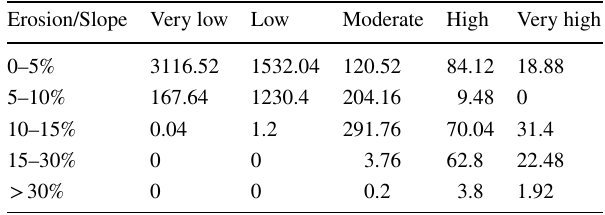
Table 8 Relationship between erosion sensitive area and slope Erosion/Slope Very low Low